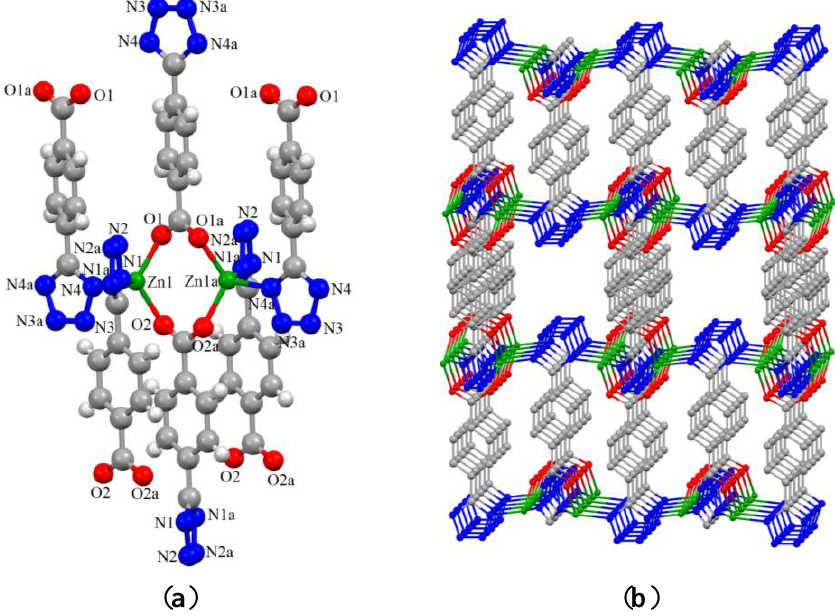
Figure 5. ( a ) Coordination of Zn and TBC ligands in 4 . Symmetry codes, A: − x , y , − z − 1/2; B: − x + 1, y , − z + 1/2; C: − x + 1, y , − z − 1/2; D: − x + 1, − y , − z ; E: − x + 1/2, − y + 1/2, − z ; ( b ) The Channels structures along a-axis. Hydrogen atoms are omitted for clarity (Zn: green, C: gray, N: blue, O: